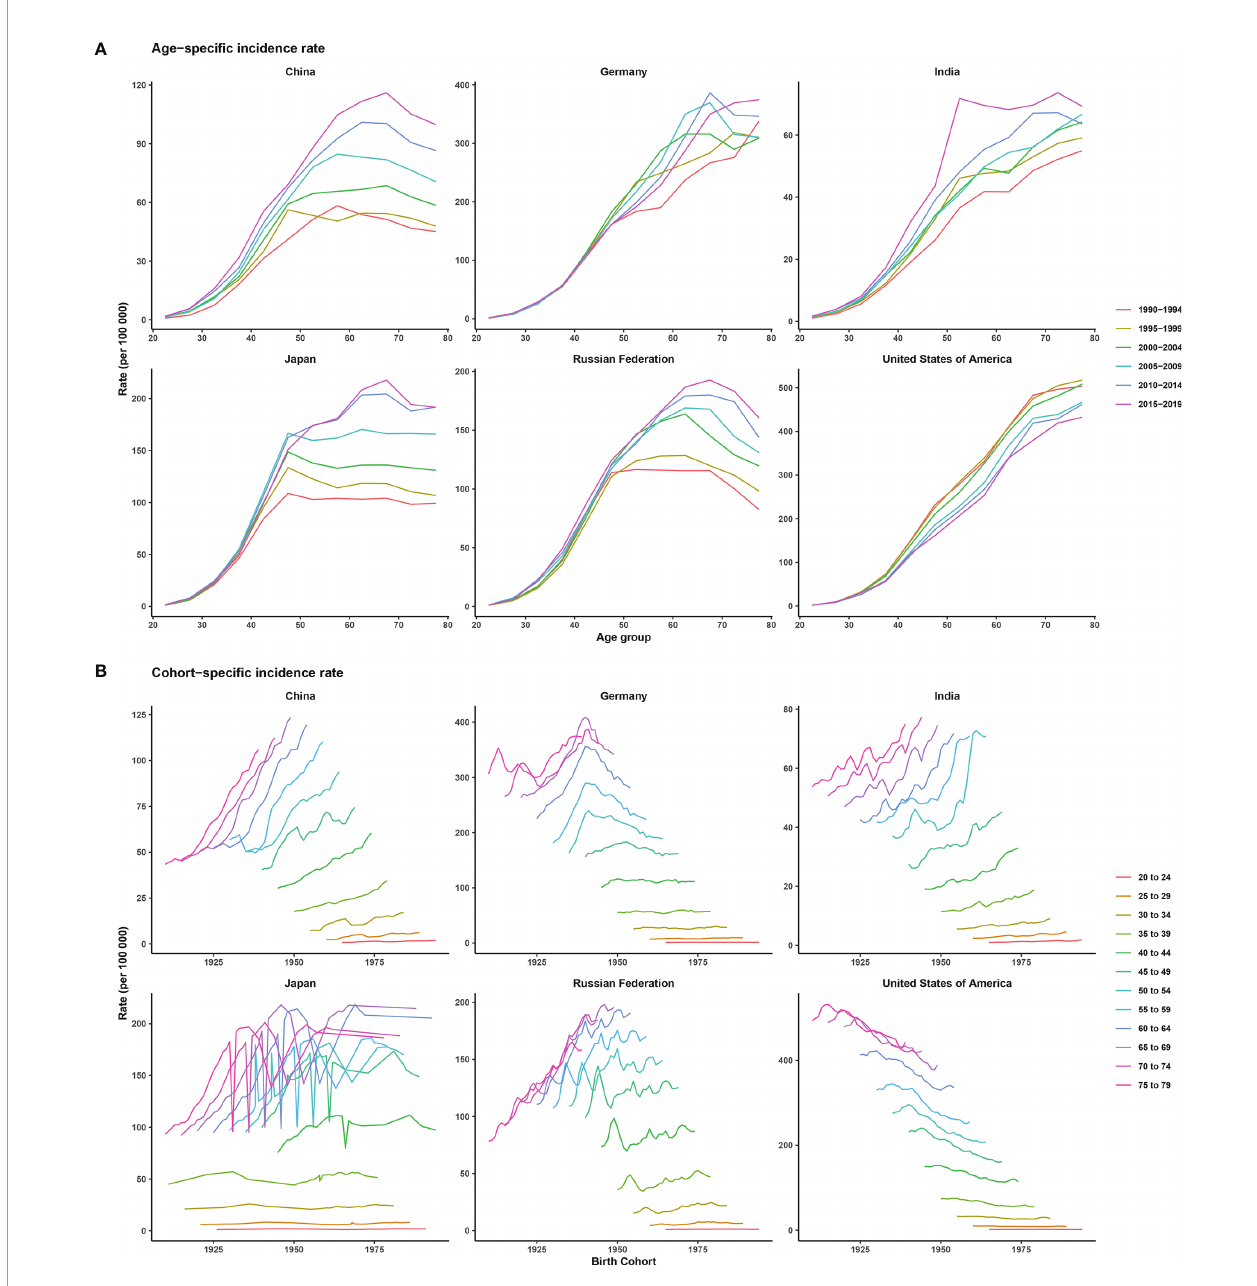
FIGURE 2 | Age-speci fi c incidence rates by period and cohort-speci fi c incidence rates by age group of female breast cancer across six most burdensome countries from 1990 to 2019. Note: The six most burdensome countries include China, Germany, India, Japan, Russian Federation, and the United States of America. (A) age- speci fi c incidence rate, survey years were arranged into six consecutive 5-year periods from 1990-1994 (median 1992) to 2015-2019 (median 2017), longitudinal age curves were estimated by age-period-cohort model and indicated the expected age-speci fi c rates of incidence. (B) cohort-speci fi c incidence rate, people aged 20 to 79 were divided into twelve consecutive 5-year age groups from 20-24 (median 22) to 75-79 (median 77), thus we have 17 consecutive birth cohorts, including those born from 1908-1912 (median 1910) to 1988-1992 (median